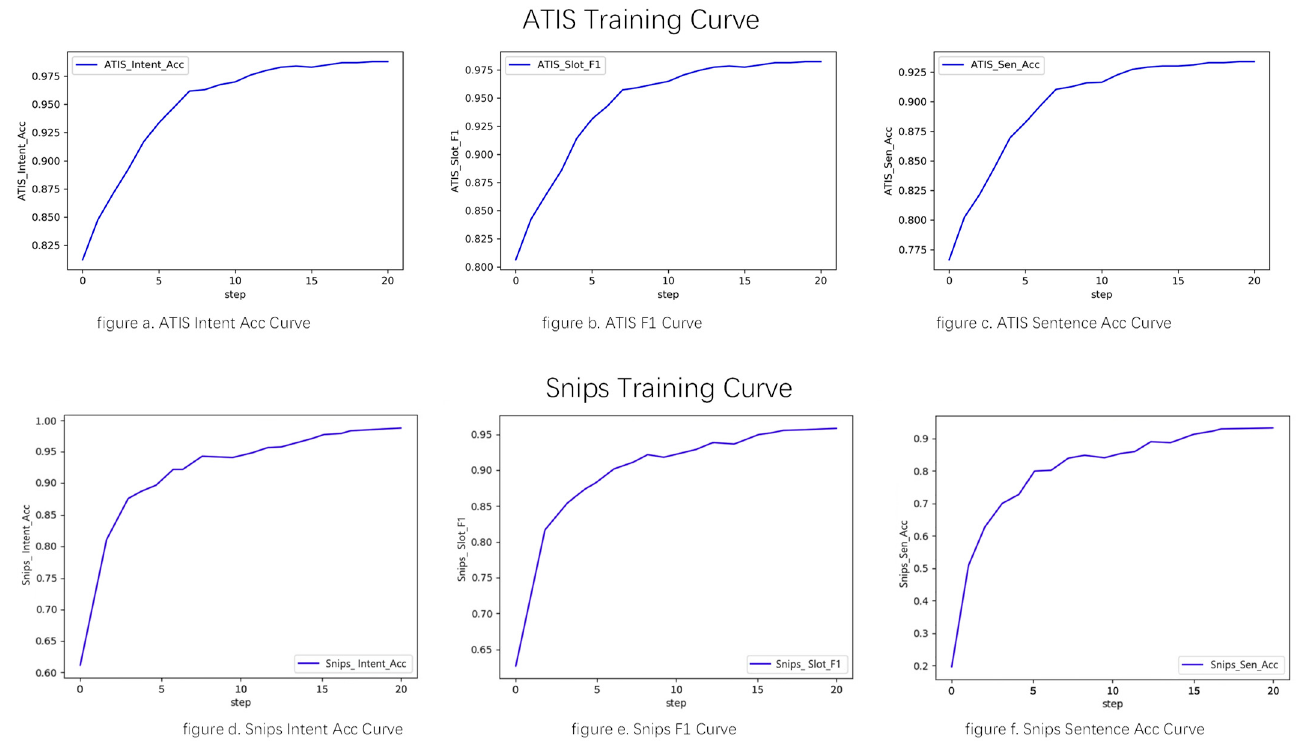
Figure 5. Training curves for accuracy, F1, and sentence accuracy on ATIS and Snips